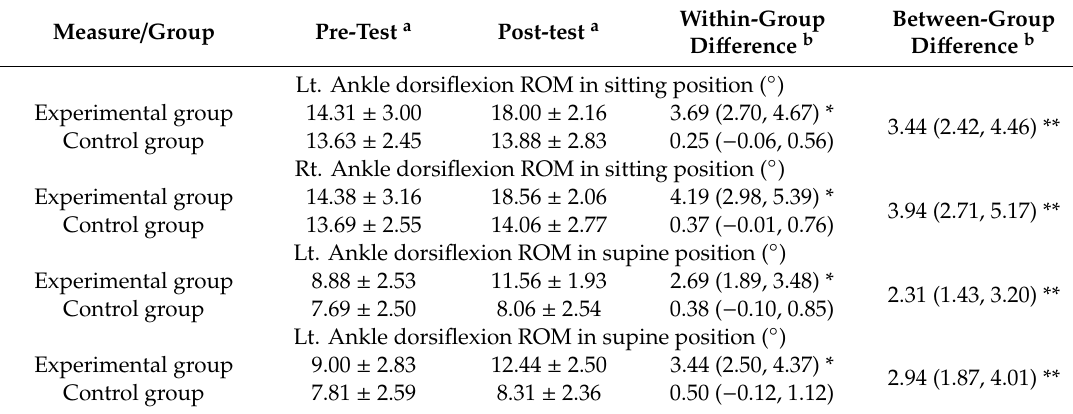
Table 2. Comparison in dorsiflexion ROM pre- and